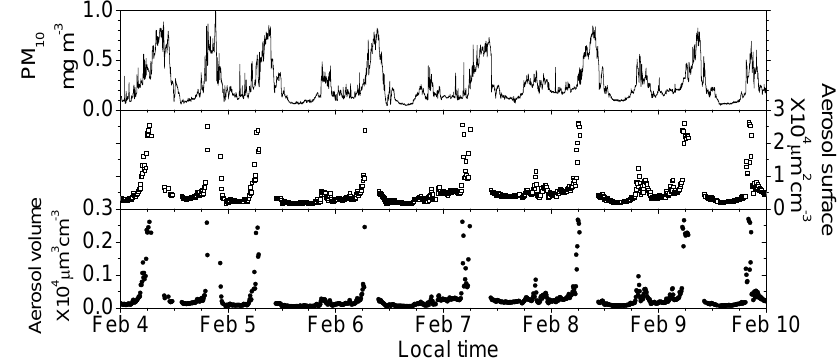
Fig. 2. PM 10 , aerosol surface and volume measured in Kathmandu, 2003. Figure 2. PM , aerosol surface and volume measured in Kathmandu, 2003. Figure 2. PM 10 , aerosol surface and volume measured in Kathmandu, 2003. 10